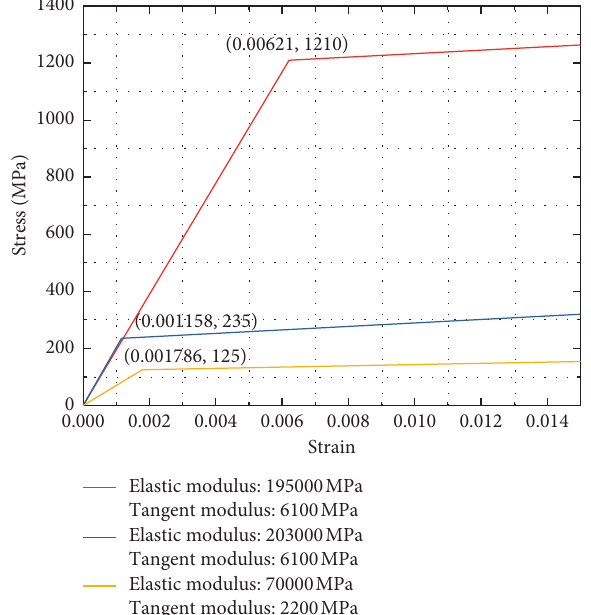
Figure 4: Stress-strain curves of the strain clamp and conductor materials.